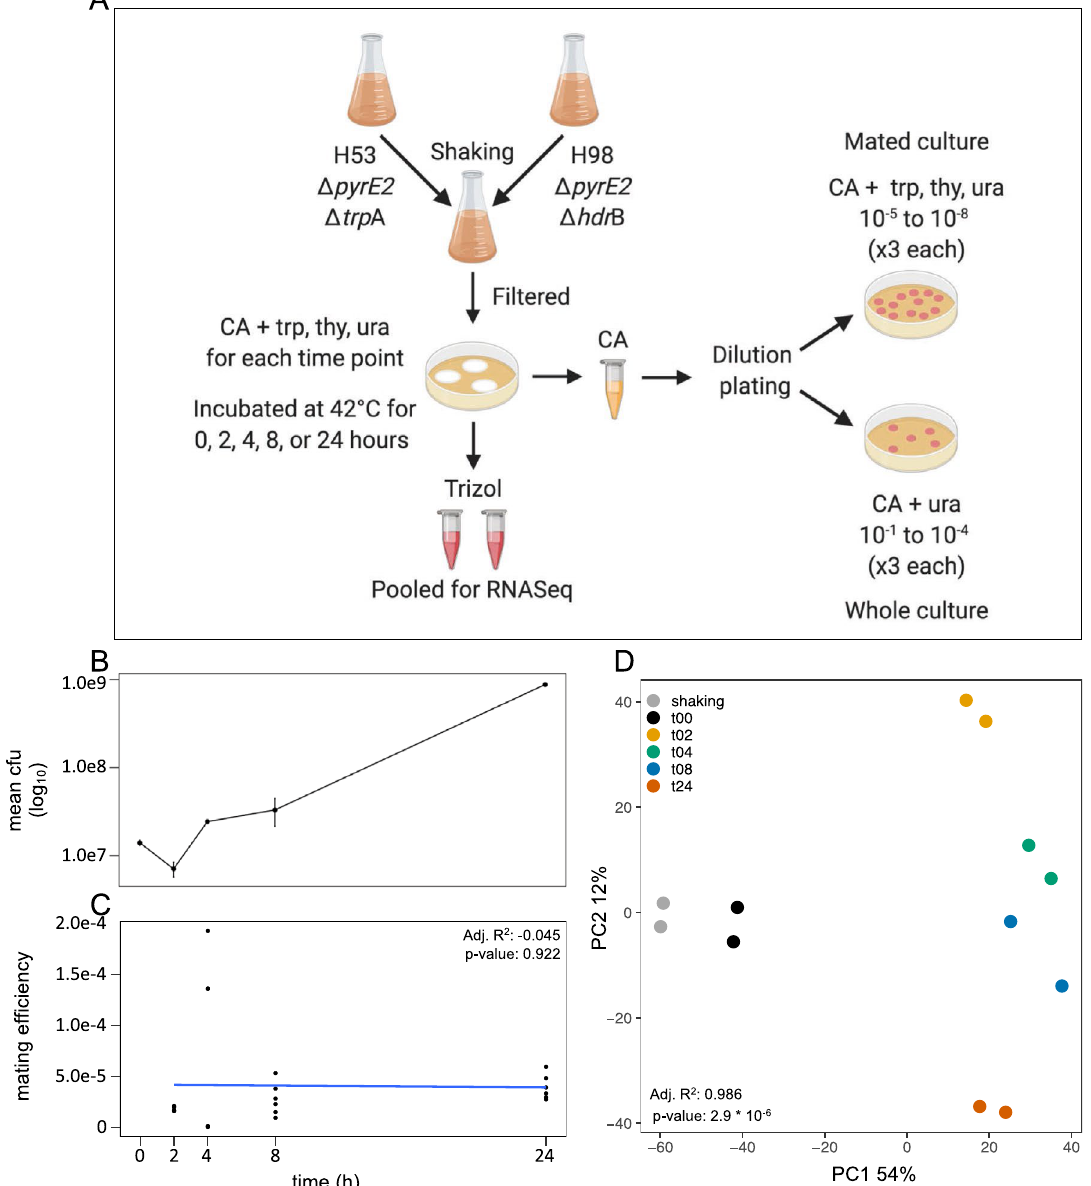
of Haloferax volcanii plotting mean cfu on log 10 scale (standard error bars based on triplicate plates for two replicates; raw data are in Supplementary Table S1); ( C ) mating efficiency based on triplicate plates for